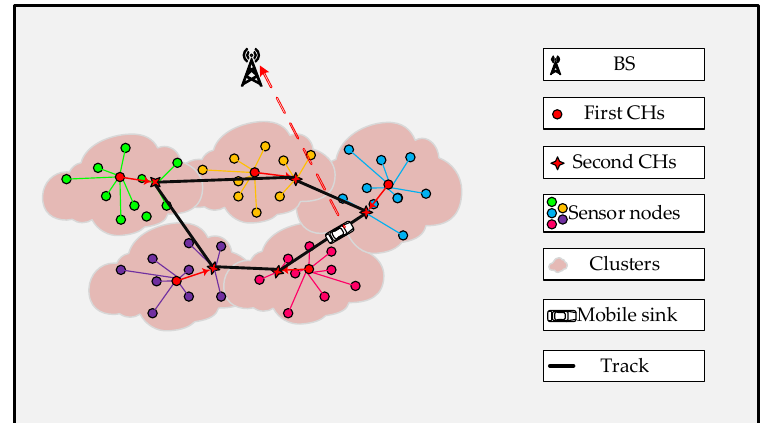
Figure 1. Data collection.